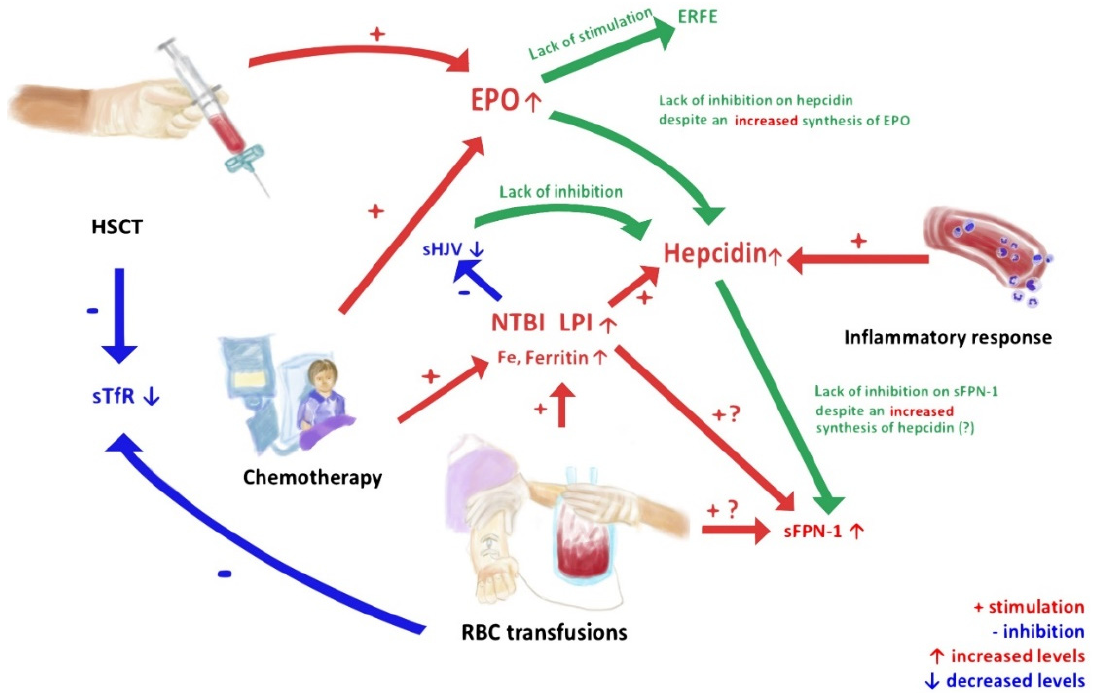
Figure 1. Flow chart of impact of anti-leukemic therapy and blood transfusions on mechanisms of iron overload metabolism.